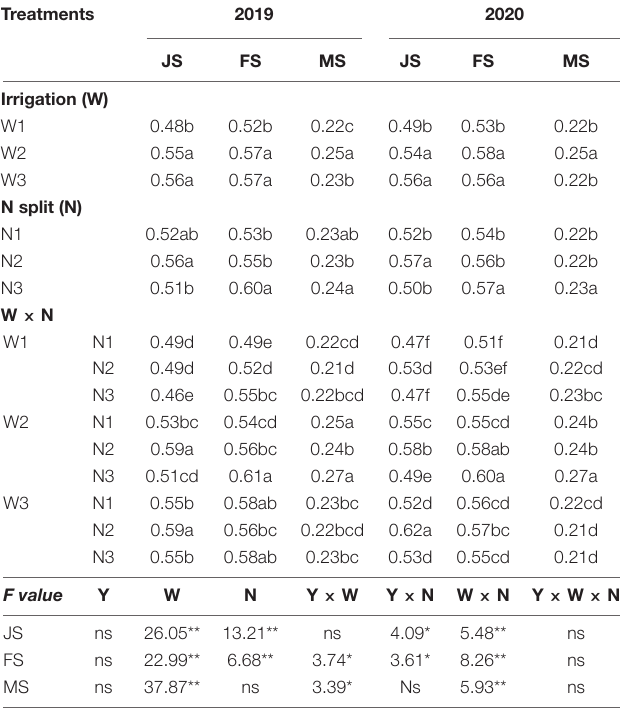
TABLE 2 | Effect of the irrigation methods and N split applications on the root-shoot ratio (R/S). Treatments